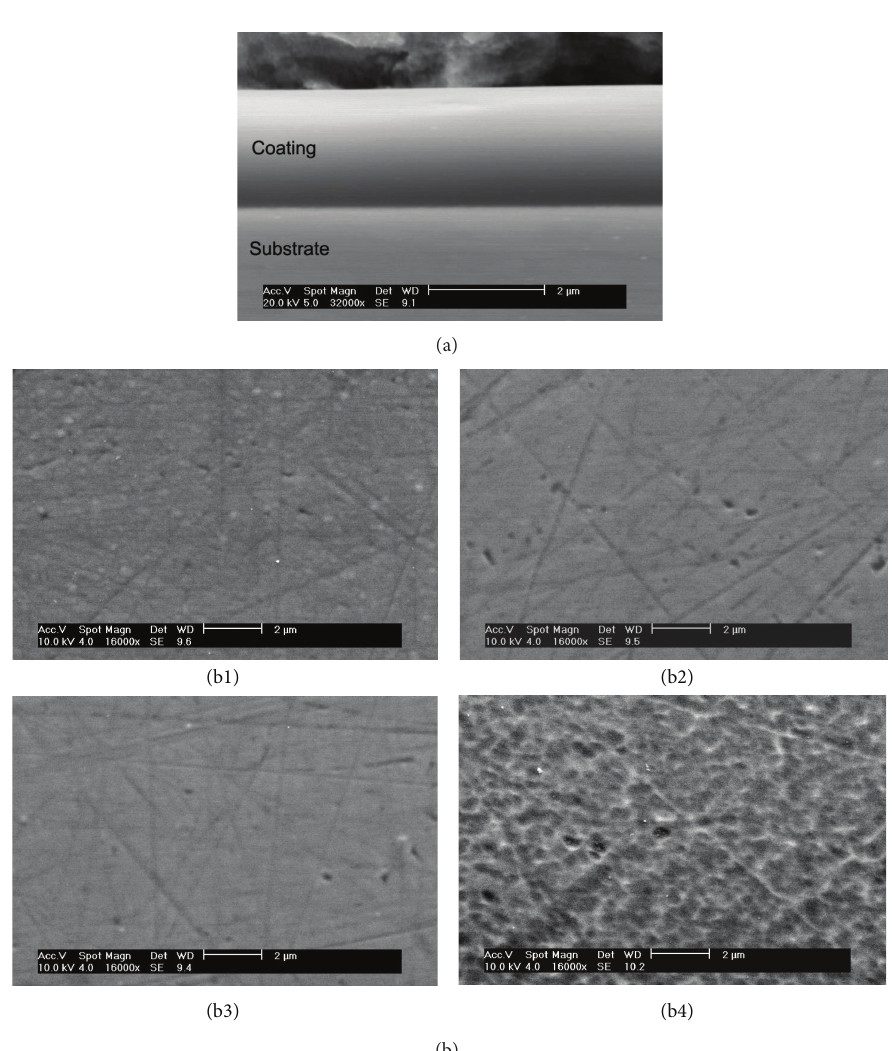
Figure 2: (a) Cross-sectional SEM image of a-SiC 1.02 :H coating; (b) SEM images of (b1) a-SiC 0.59 :H, (b2) a-SiC 0.75 :H, (b3) a-SiC 0.89 :H, and (b4) a-SiC 1.02 :H